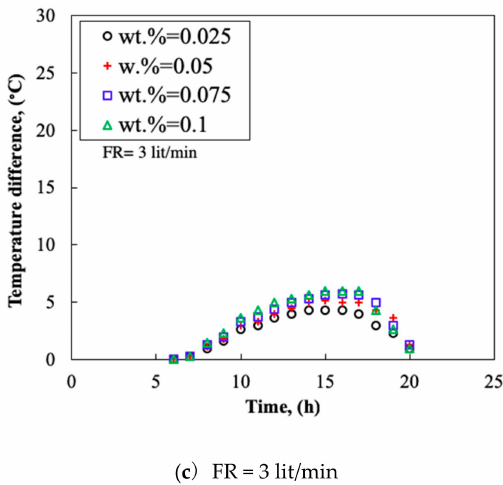
Figure 14. Variation of the temperature di ff erence with time for various concentration of CNPs.